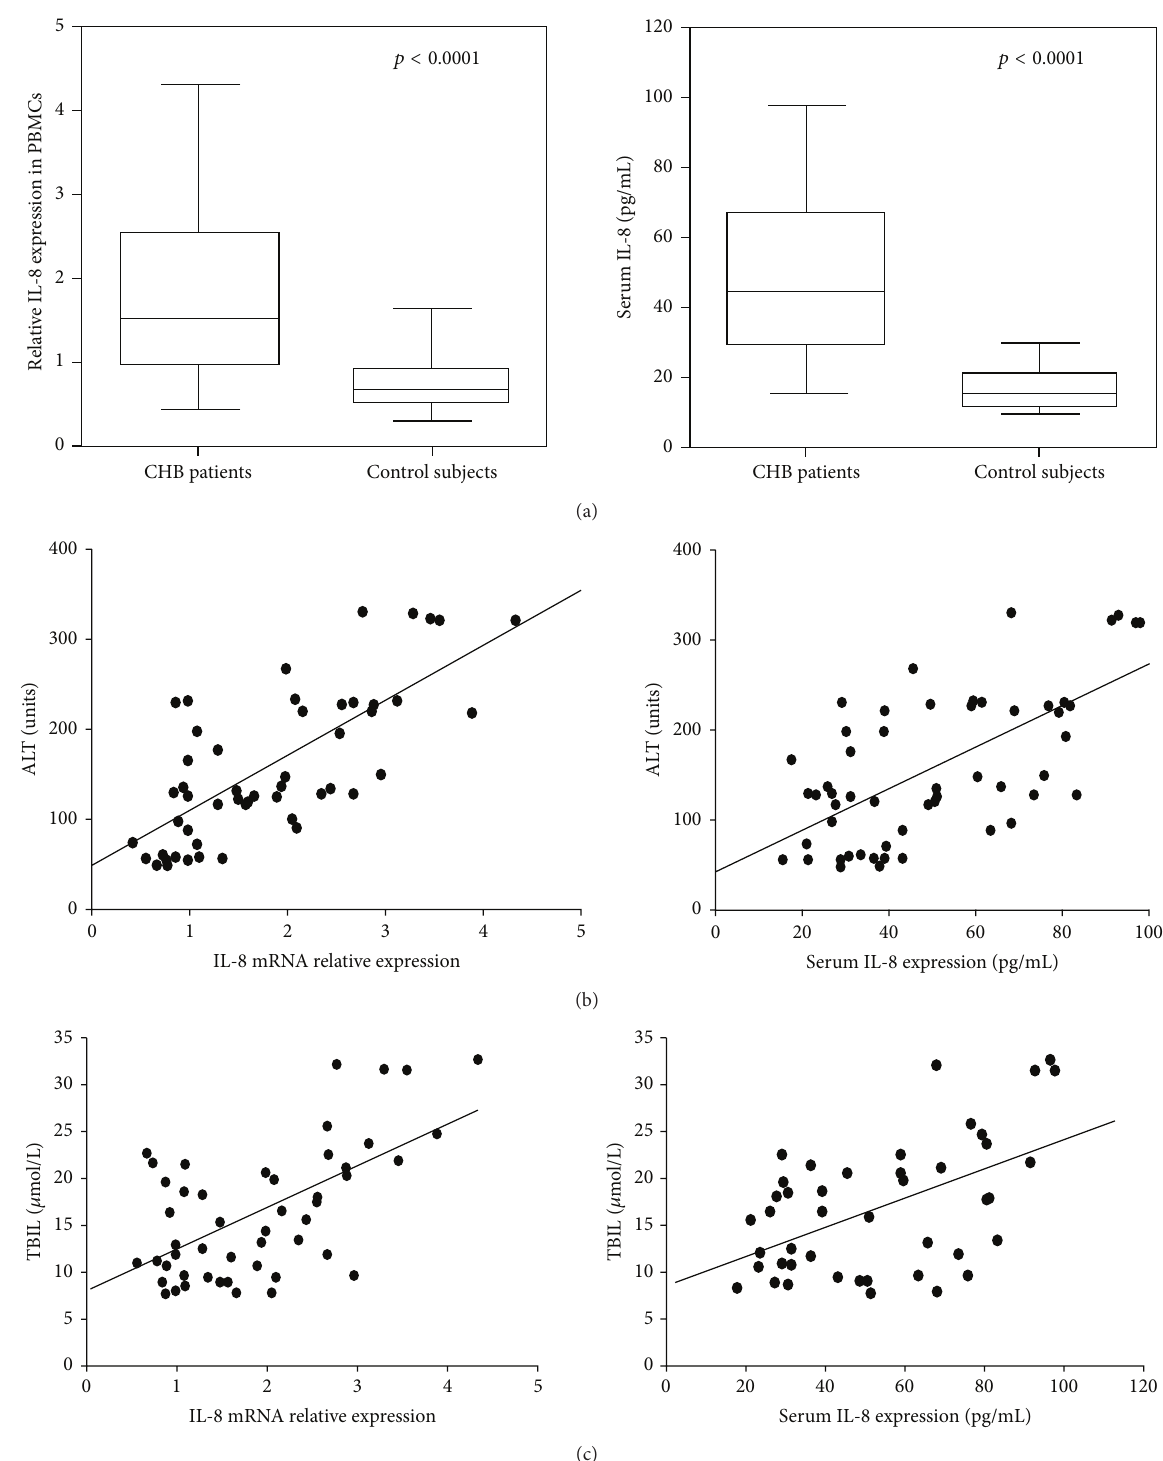
Figure 2: Serum IL-8 protein and mRNA levels were significantly increased in CHB patients and were positively correlated with serum ALT. (a) Serum IL-8 and PBMCs IL-8 mRNA of 56 CHB patients and 40 healthy controls were assessed by ELISA and qRT-PCR. (b) Both serum IL-8 and PBMCs IL-8 mRNA were positively correlated with serum ALT levels. (c) Both serum IL-8 and PBMCs IL-8 mRNA were positively correlated with TBIL